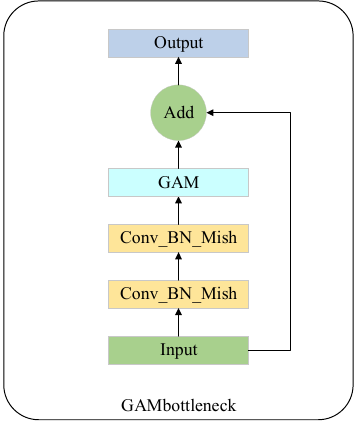
Figure 5. The structure of the GAM bottleneck.